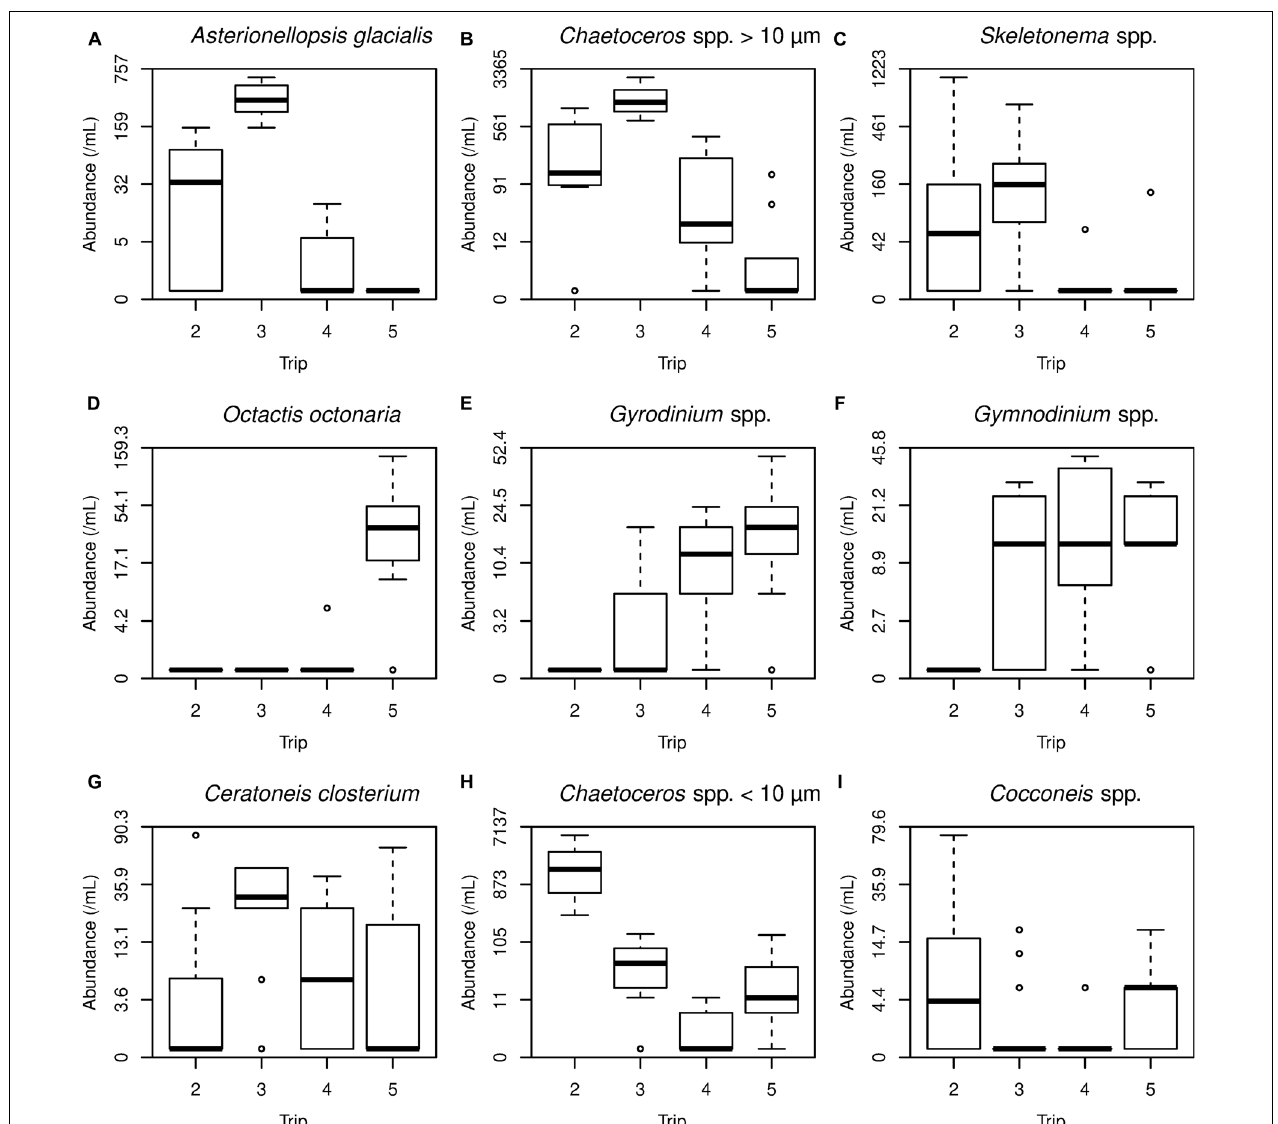
FIGURE 11 | Boxplots showing variation in selected phytoplankton species by trip. The graphs are ordered according to PCA species scores: PCA1 positive (A–C) , negative (D–F) ; PCA2 positive (G) , negative (H, I) . For example, A. glacialis was more abundant on trips 2 and 3, whose samples were mostly positive on